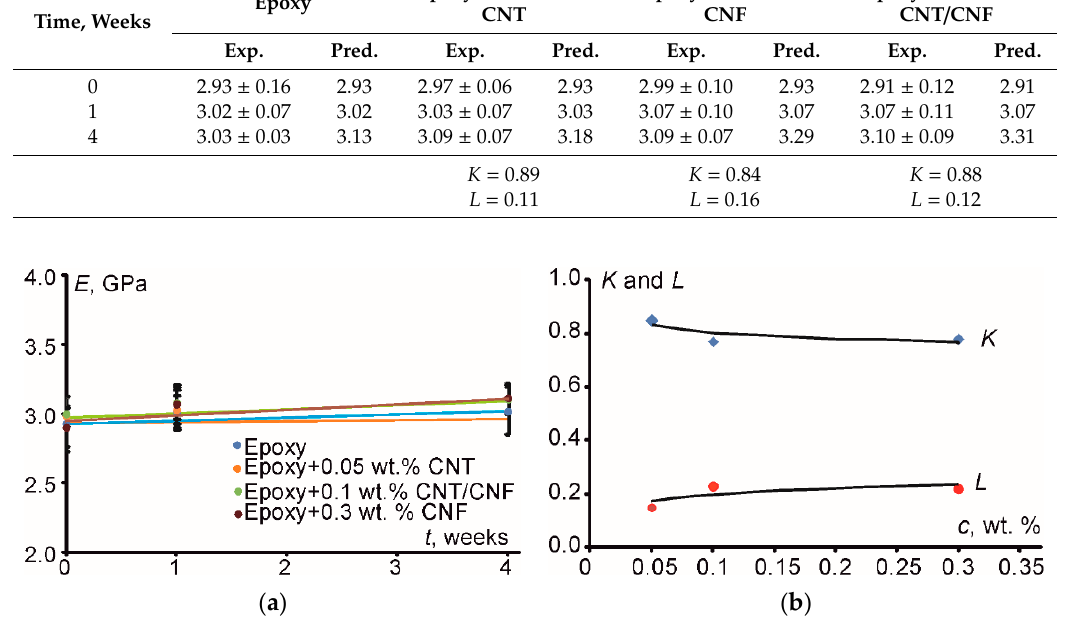
Figure 7. Experimental results and respective theoretical predictions by using PPM for ( a ) the elastic modulus variation of the investigated materials (indicated in the legend) with aging time at 70 °C and ( b ) variation of the degrees of adhesion ( K ) and dispersion ( L ) with filler concentration for specimens aged at 70 °C (dots—experimental data, lines—PPM prediction).